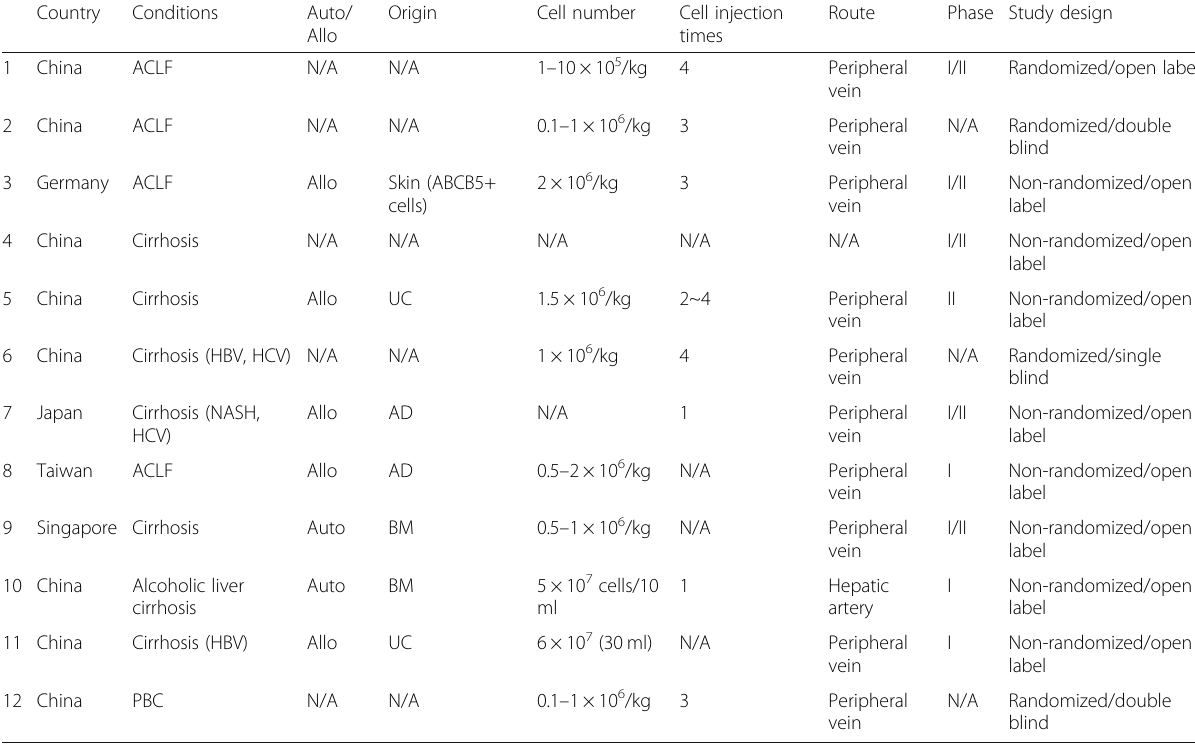
Table 1 Recently started or planned clinical trials